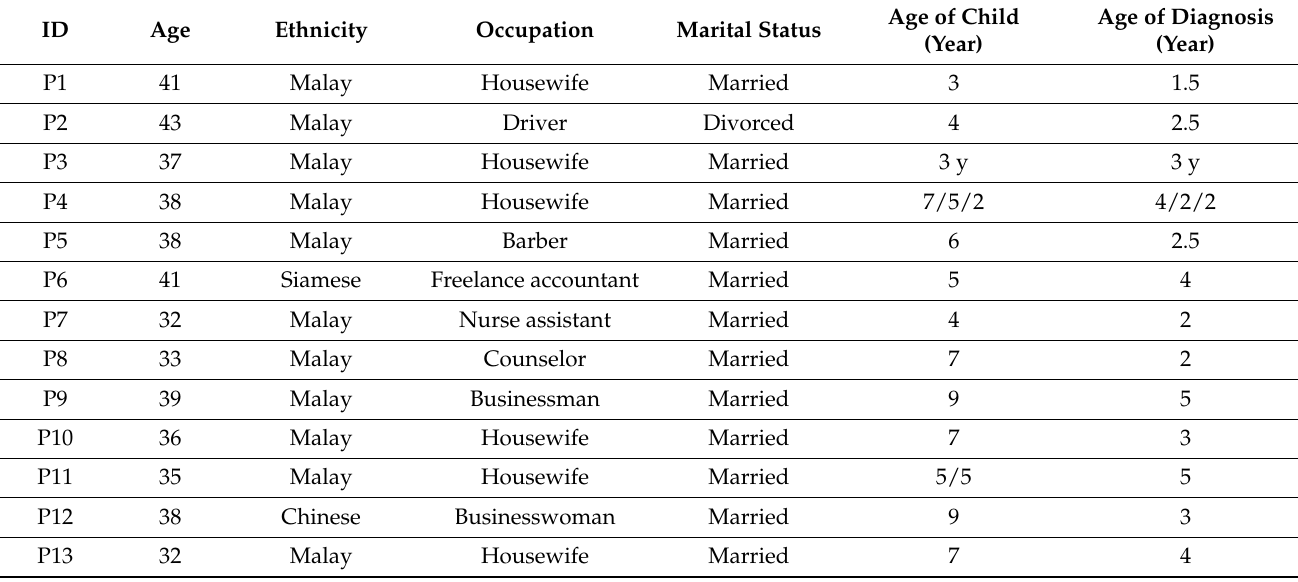
Table 1. Characteristics of study